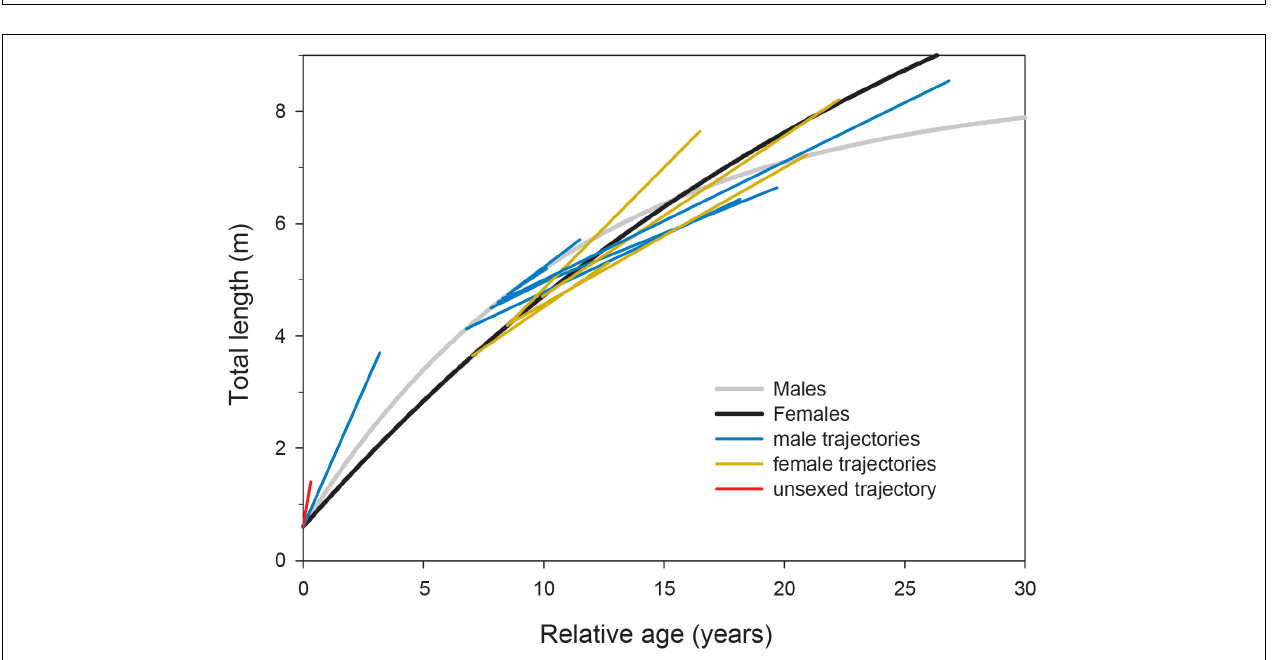
FIGURE 3 | (A) Male and female growth profiles from the von Bertalanffy growth model fitted to resighting data from 48 male and 6 female whale sharks. (B) Bivariate confidence data clouds of paired estimates of von Bertalanffy growth parameters K and L ∞ based on 200 bootstrapped re-estimates. White boxes represent coordinates of mean parameter estimates.